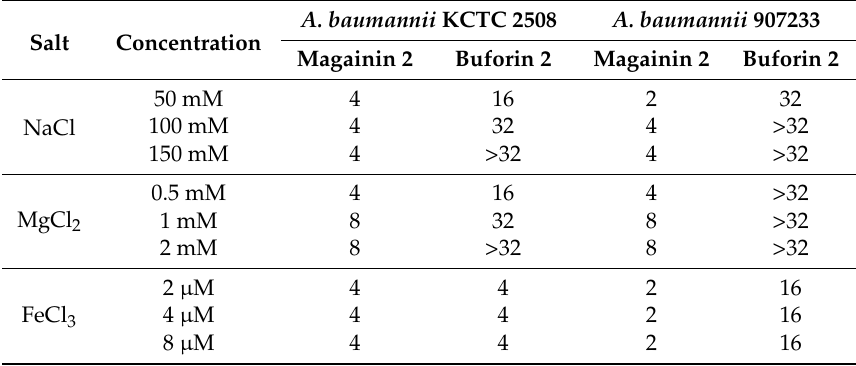
Table 4. MIC values of peptides in the presence of physiological salts.